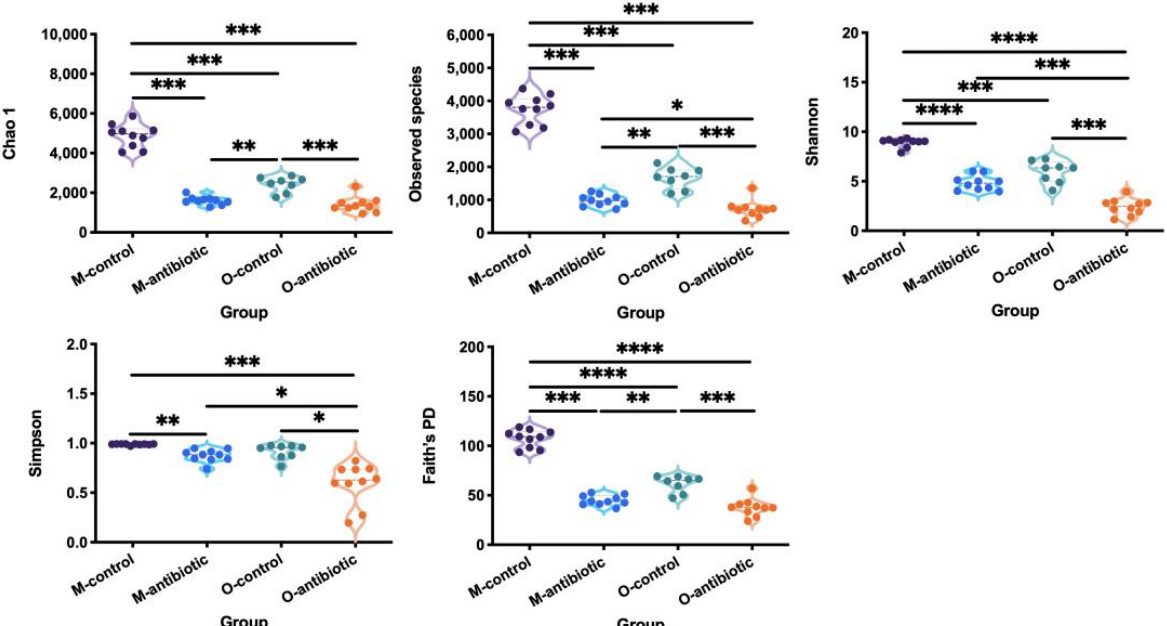
Figure 1. Comparison of the α -diversity indices (Chao 1, the number of species, Shannon, Simpson